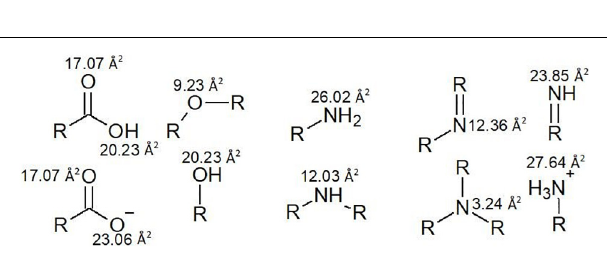
FIGURE 3 | Solubility across a series of hydroxylated aromatics. Hydrophilicity (aqueous solubility) increase with the number of polar groups and the strength of polar groups (see Figure 2 ). Methylation of OH groups significantly reduces hydrophilicity, as does esterification of acid groups. Similar outcomes occur with acetylation or esterification with alkyl chains, with longer chains having progressively lesser hydrophilicity.